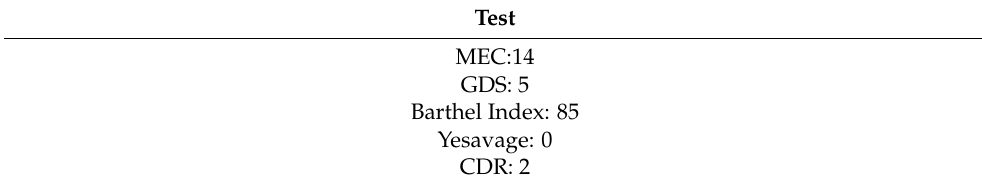
Table 1. Results of the MEC, GDS, Barthel, Yesavage, and CDR tests, applied on 31 January